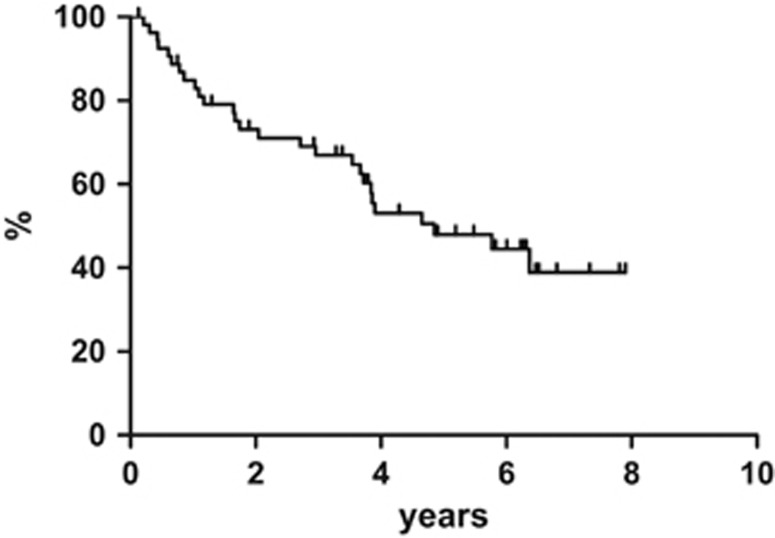
Overall survival.